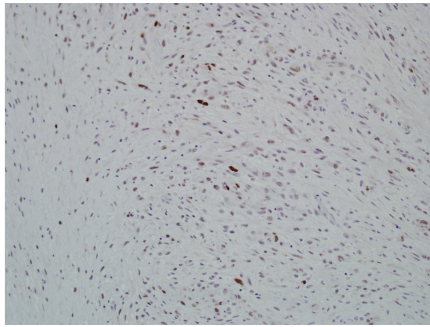
Figure 8: P 53 immunopositivity of MTNST was apparent.